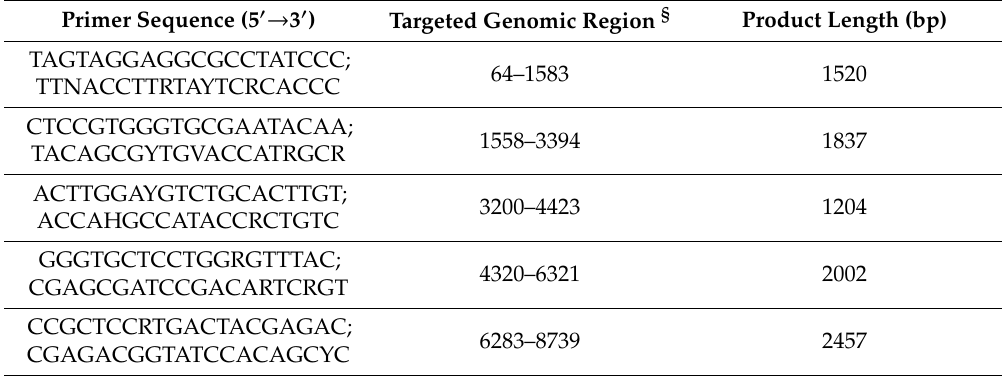
Table 2. The information on the PCR primers used for amplifying the BovHepV genomes in the present study. § Numbered according to BovHepV strain BovHepV_463 / Ger / 2014. Primer Sequence (5 (cid:48) → 3 (cid:48) ) Targeted Genomic Region § Product Length